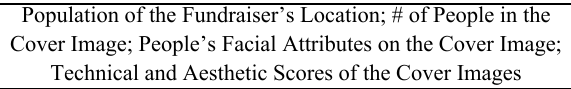
Technical and Aesthetic Scores of the Cover Images